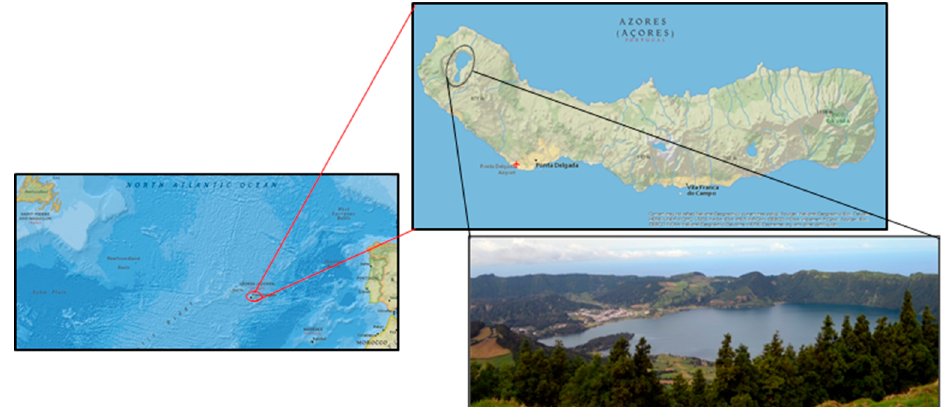
Figure 1. Photo of Sete Cidades village, its position on the map of São Miguel Island, Azores, and the relative position of Azores archipelago in the Atlantic Ocean (Maps are not to scale).